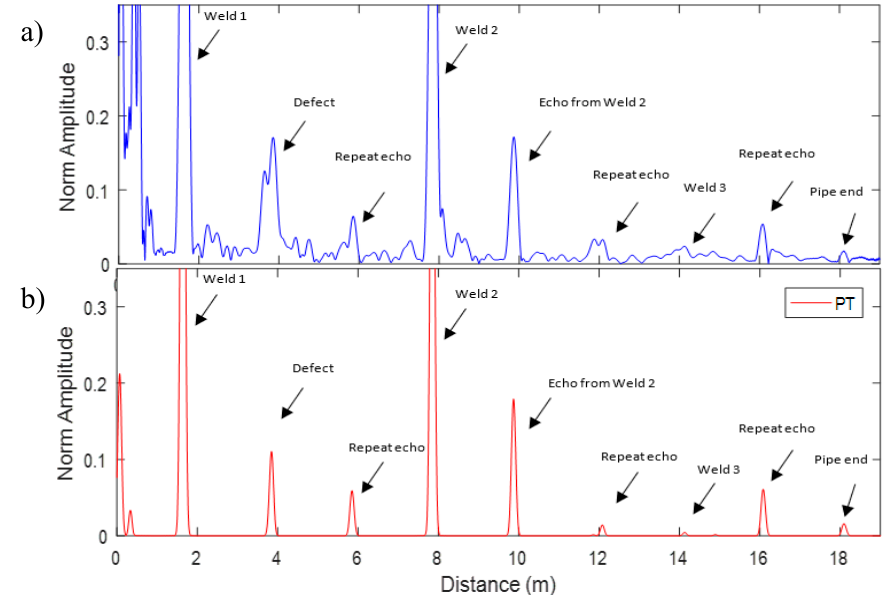
Figure 11. Pipe B result for ( a ) unprocessed Teletest data, ( b ) SSP result for the whole length of the trace.